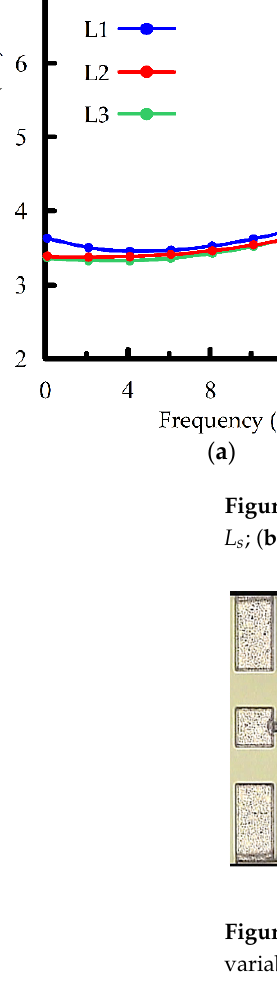
Figure 3. The simulated performances of inductors L1, L2, and L3. ( a ) The simulated series induct- ance L s ; ( b ) the simulated Q-factor.